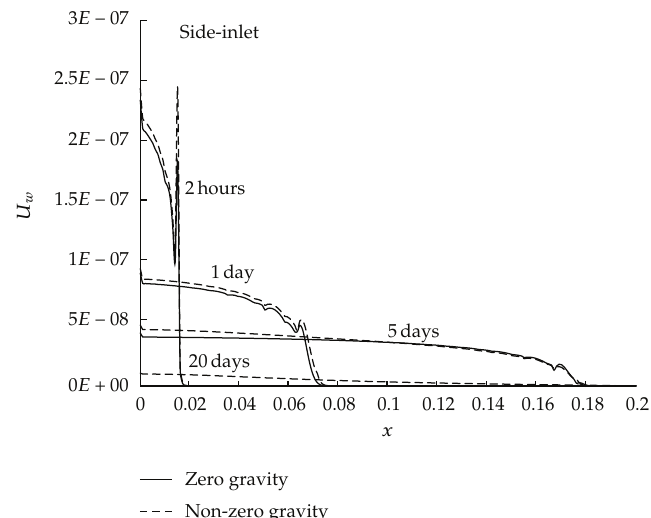
Figure 7: Comparison between considering and neglecting gravity e ff ect on water x -velocity for the side- inlet case, at z (cid:8) 0 .